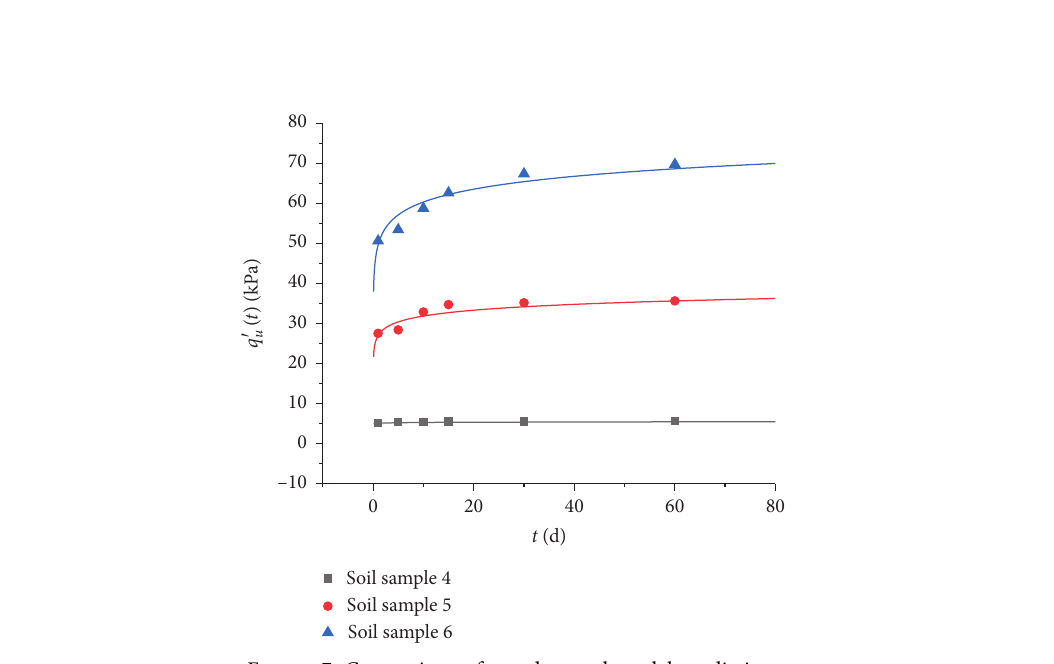
Figure 7: Comparison of test data and model prediction.